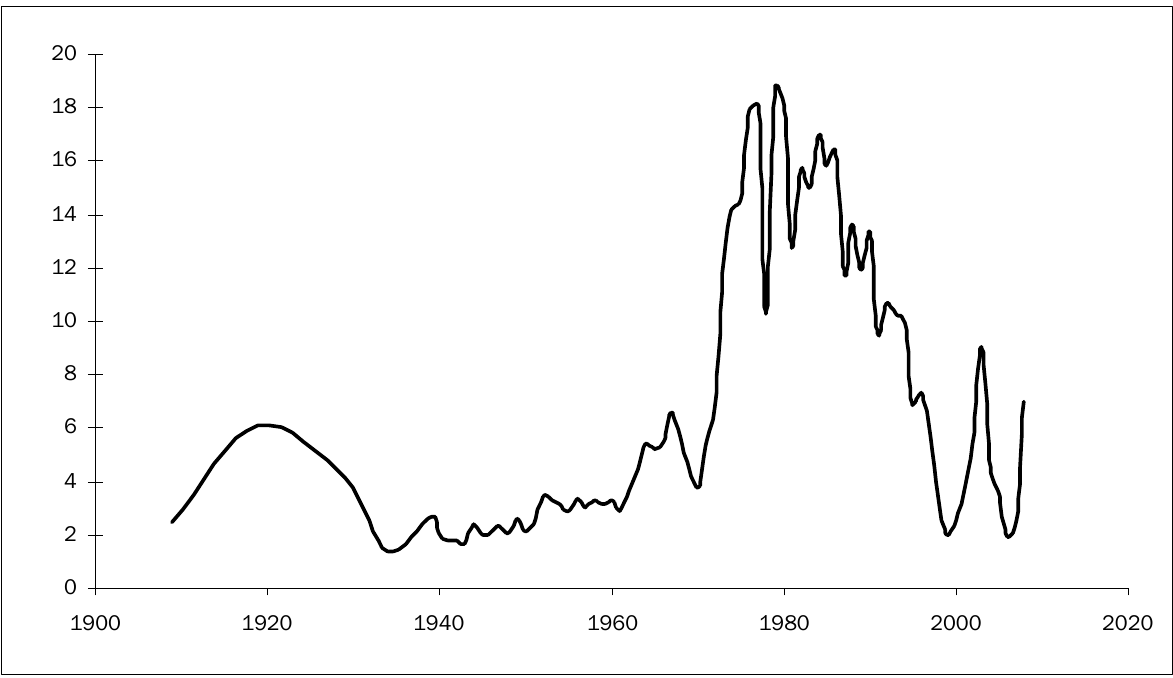
Figure 1. Annual Wheat Yields for Oregon’s Northwest District, 1990–2010 (Millions of bushels)